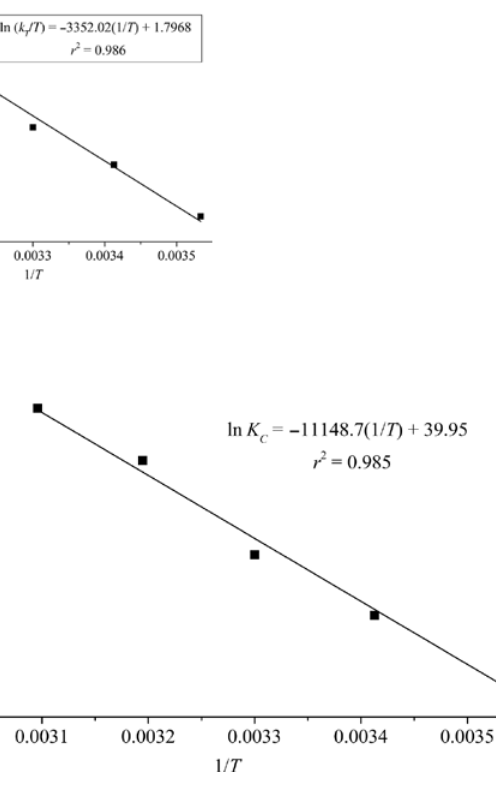
Figure 13: Van’t Hoff plot for DBT catalytic oxidation.